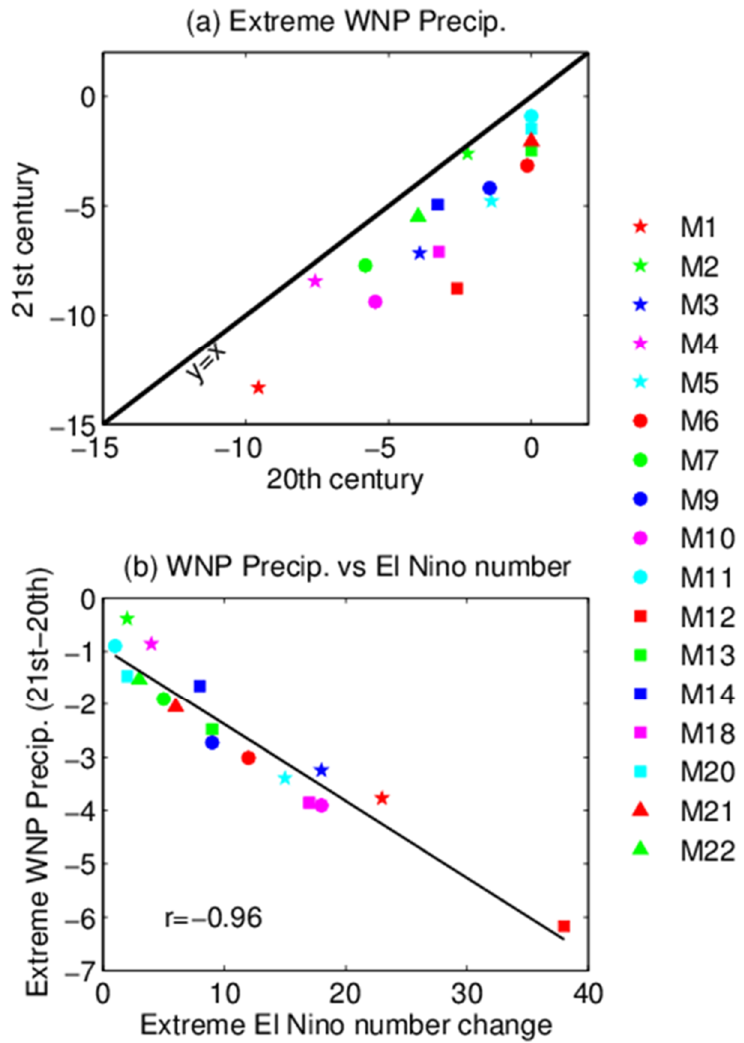
Figure 12. ( a ) Comparison of DJF precipitation anomalies (mm/day) over the WNP caused by extreme El Niño events during the 20th versus the 21st century. The precipitation anomalies were normalized by the corresponding WNP DJF mean precipitation for each model. ( b ) Scatterplot of the projected changes in WNP precipitation anomalies caused by extreme El Niño versus changes in the number of extreme El Niño events.